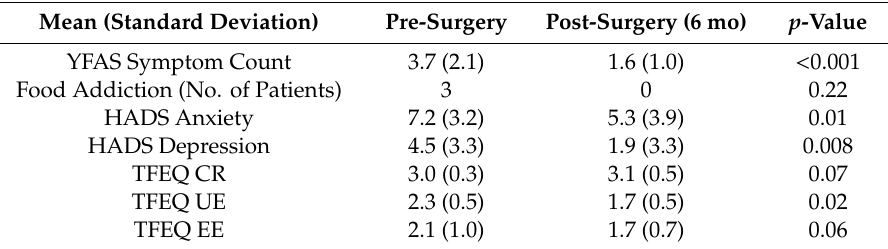
Table 2. Patient questionnaire results.